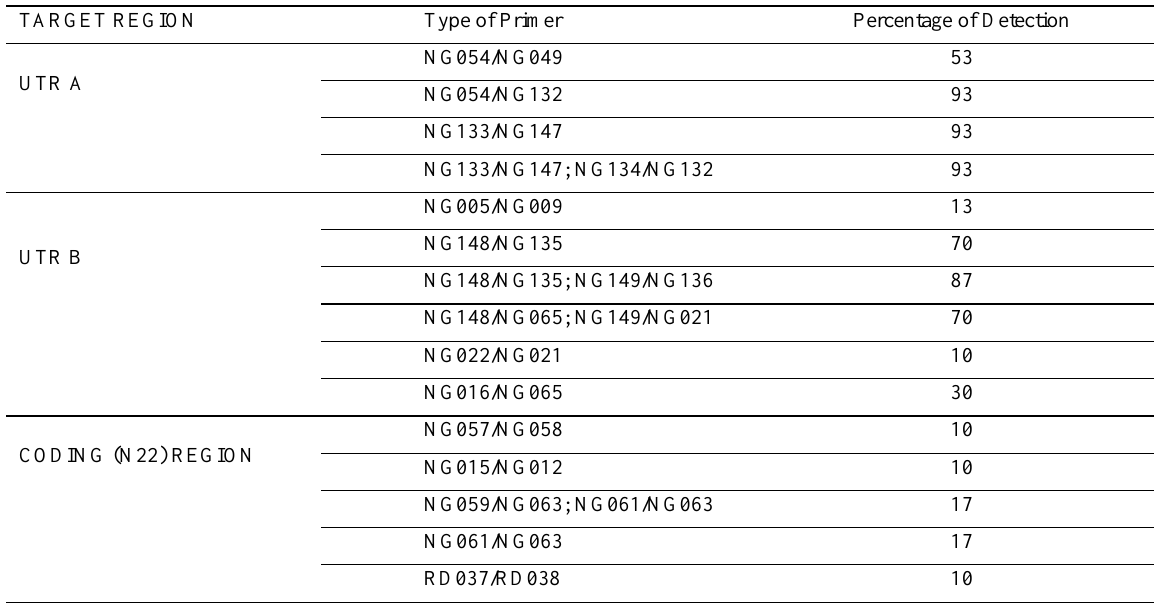
Table 1: Table retrieved from Okamoto et al., 1999 listed types of primers with the percentage of detection. The higher the percentage of detection, the higher the sensitivity of primer used in amplifying specific region.